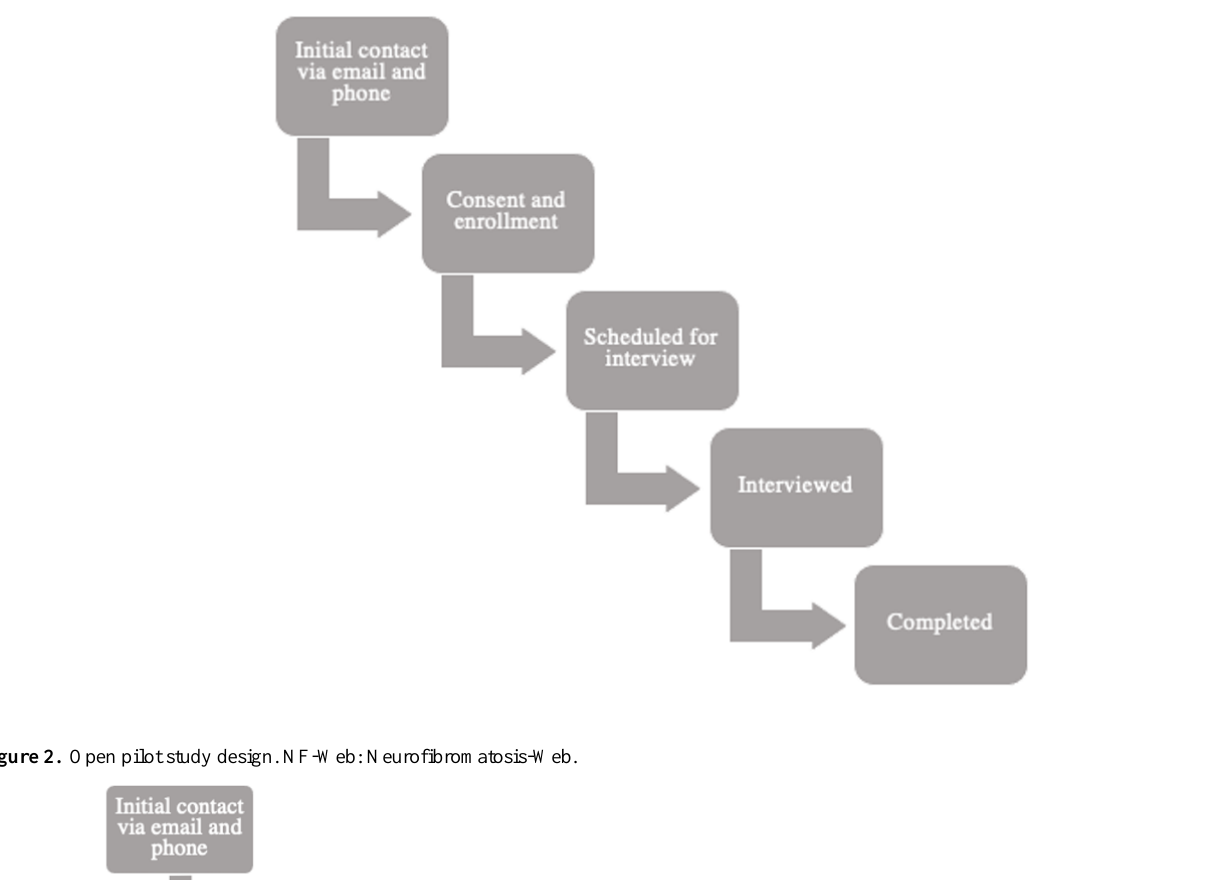
Figure 1. Qualitative study design.